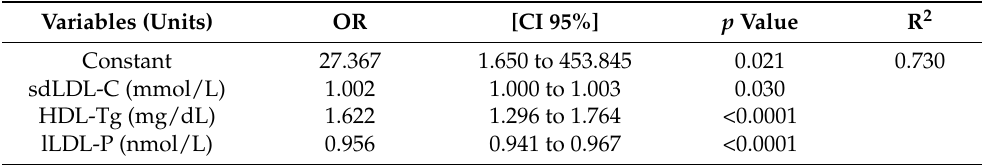
Table 3. Results of the multivariate logistic regression analysis.